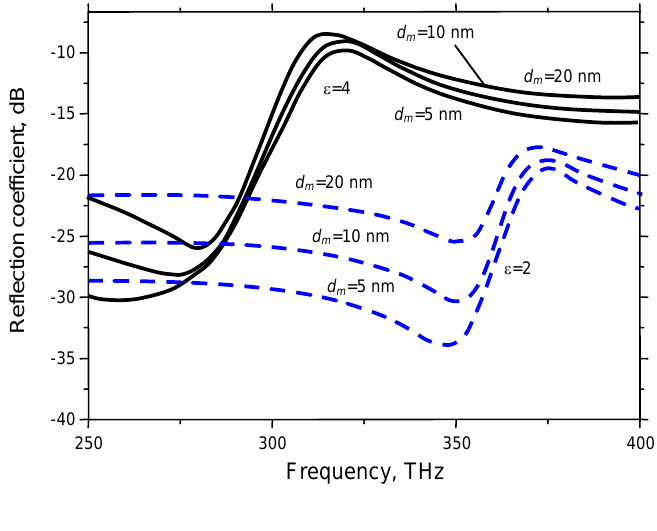
= 100 nm;  = 2 or d d